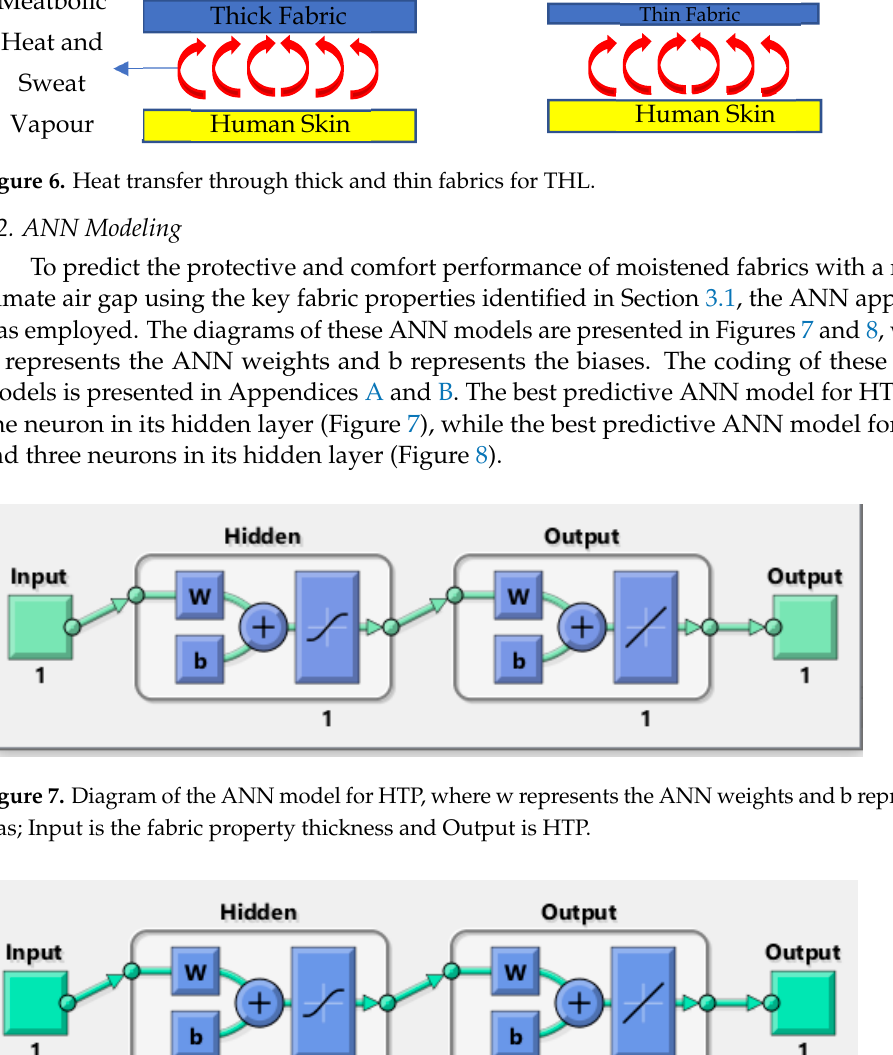
Figure 5. Heat transfer through thick and thin fabrics for HTP.